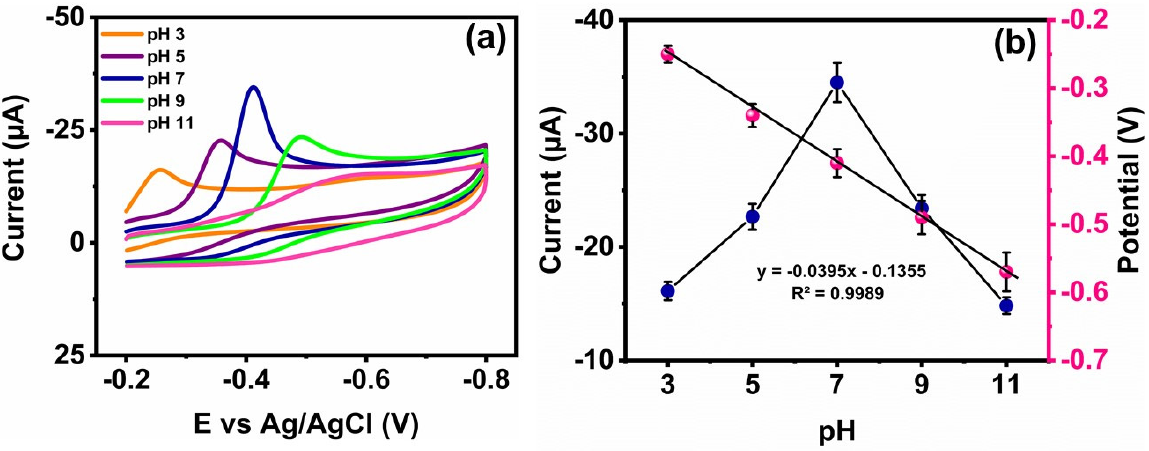
Figure 7. ( a ) CV response of FZE (100 µM) at NMO/GCE at different pH values (3–11) at a scan rate of 50 mVs − 1 and ( b ) Calibration plot for different pH values vs. current and potential.